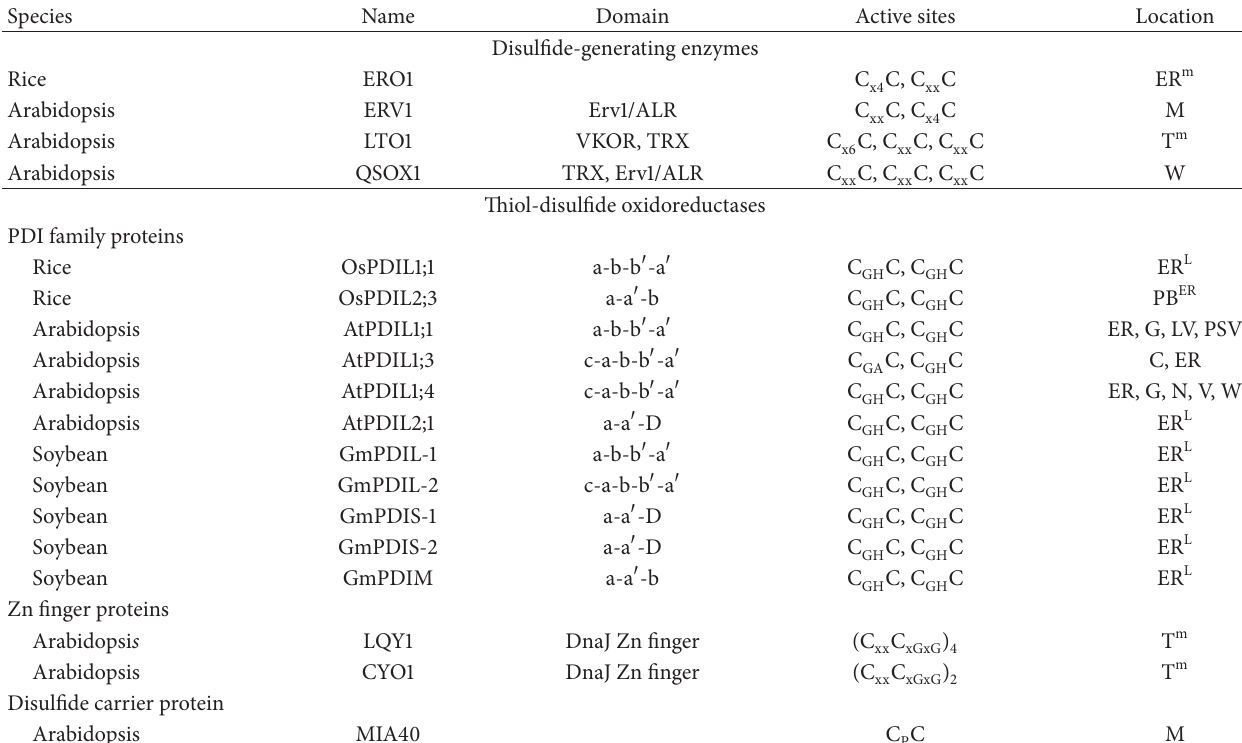
Table 1: Components of the system for disulfide bond formation in higher